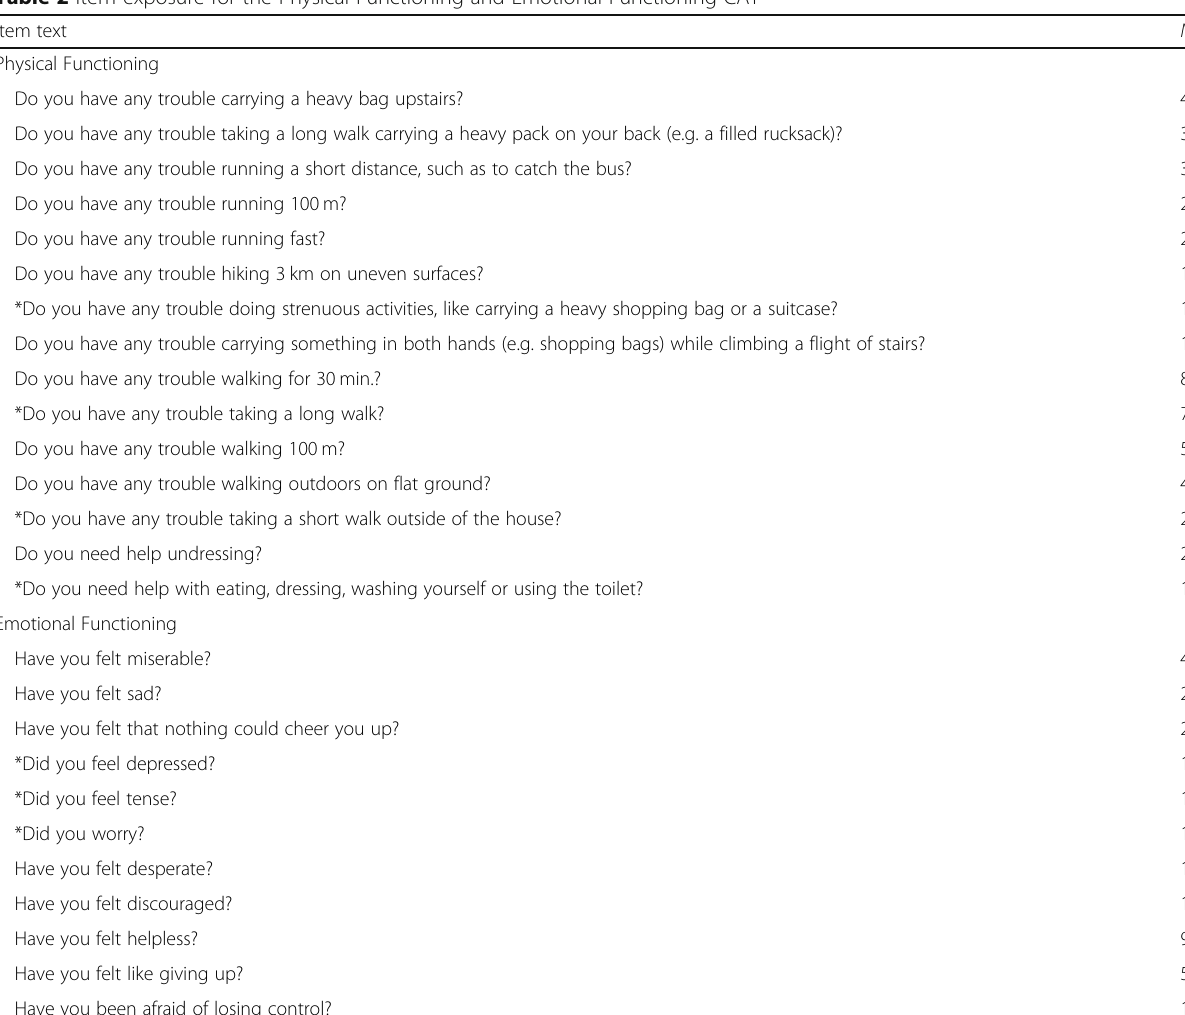
Table 2 Item exposure for the Physical Functioning and Emotional Functioning CAT